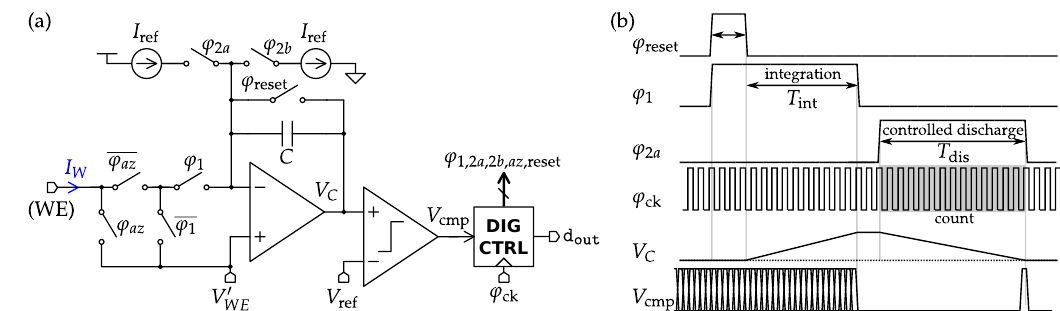
Figure 15. Potentiostats with embedded dual slope A/D conversion. ( a ) schematic; ( b ) time